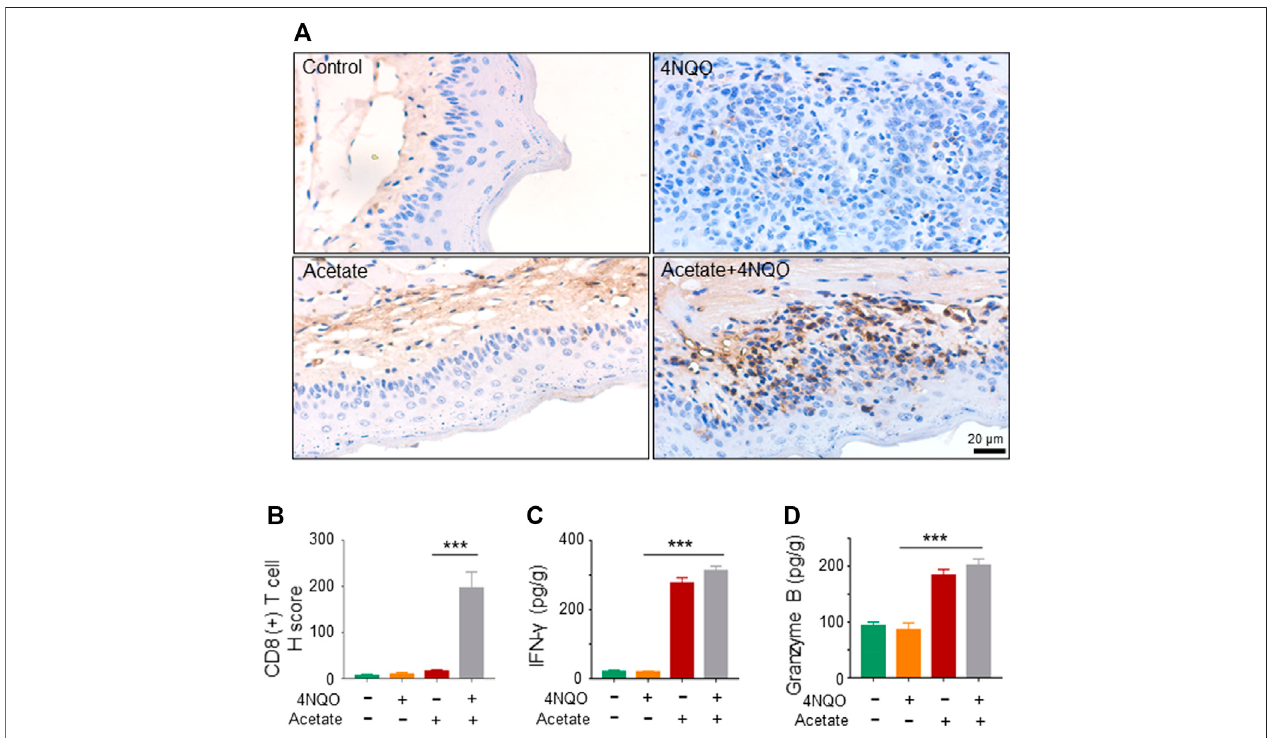
FIGURE6 | Supplementofacetateenhances murine anti-tumor immunity against OPC. The mice were treatedas described in Figure 5 . Glossopharyngeal tissue was collected for histological staining and cytokine detection. The secretion of Granzyme B and IFN- γ from tissues was detected by ELISA. (A,B) IHC staining of CD8 + T cells (A) and its quantitation (B) were performed in glossopharyngeal tissues. (C,D) The level of IFN- γ (C) and Granzyme B (D) in the glossopharyngeal tissue. Data represent mean ± SEM. *** p < 0.001, n = 5, compared with